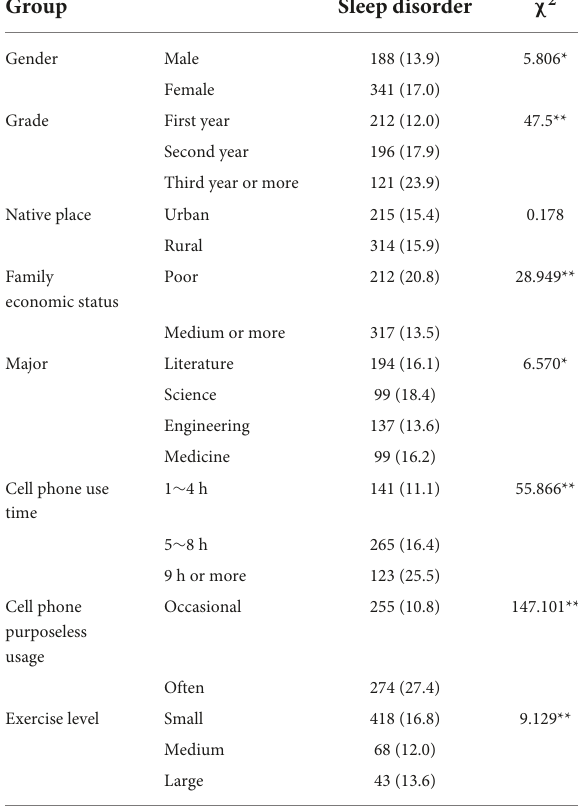
TABLE 4 Comparison of the detection rate of sleep disorders among students in different groups of universities.